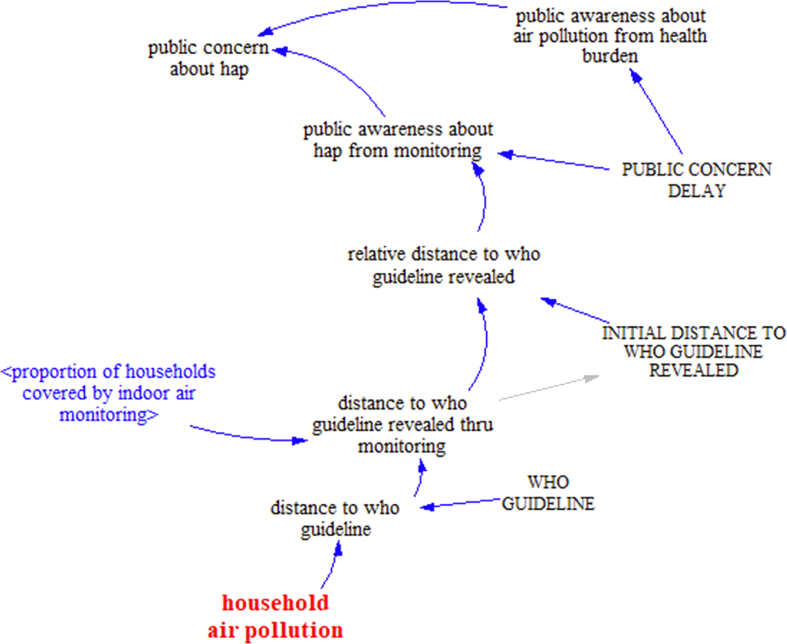
Formulation of Public concern about household air pollution.